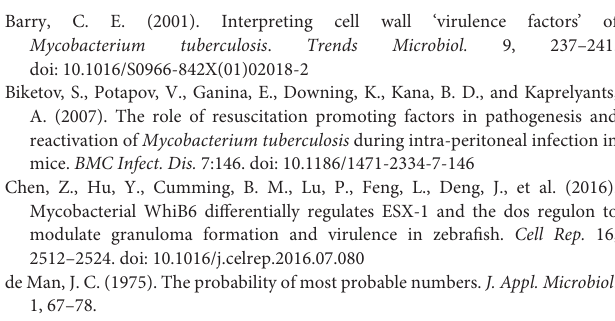
Figure S1 | Resuscitation of dormant non-culturable M. tuberculosis bacilli in the presence of rifampicin. Changes in cell characteristics in the absence (in black) and in the presence (in red) of 5 µ g/ml of rifampicin: colony forming units (circles), CFU/ml; radioactive incorporation of uracil (triangles) cpm/ml; optical density (diamonds) OD 600 . This experiment was repeated five times with similar results. Figure S2 | Expression of several protein-coding genes (A) and ncRNAs (B) at early stages of resuscitation in bacterial cultures with and without rifampicin (rif) treatment. qPCR data are normalized to 16S rRNA transcription